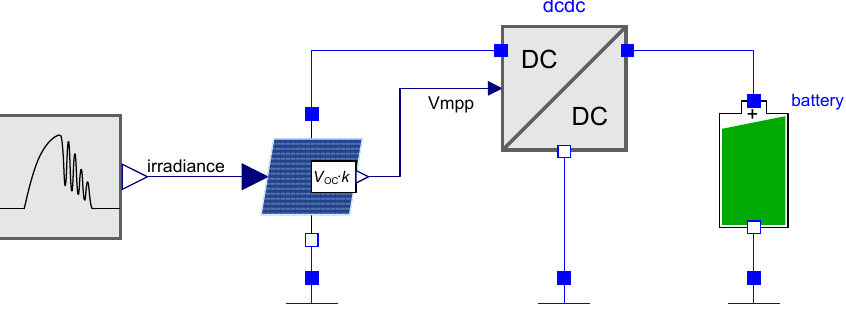
Figure 8. Simulation setup consisting of a solar irradiation simulator, a solar cell and a battery.